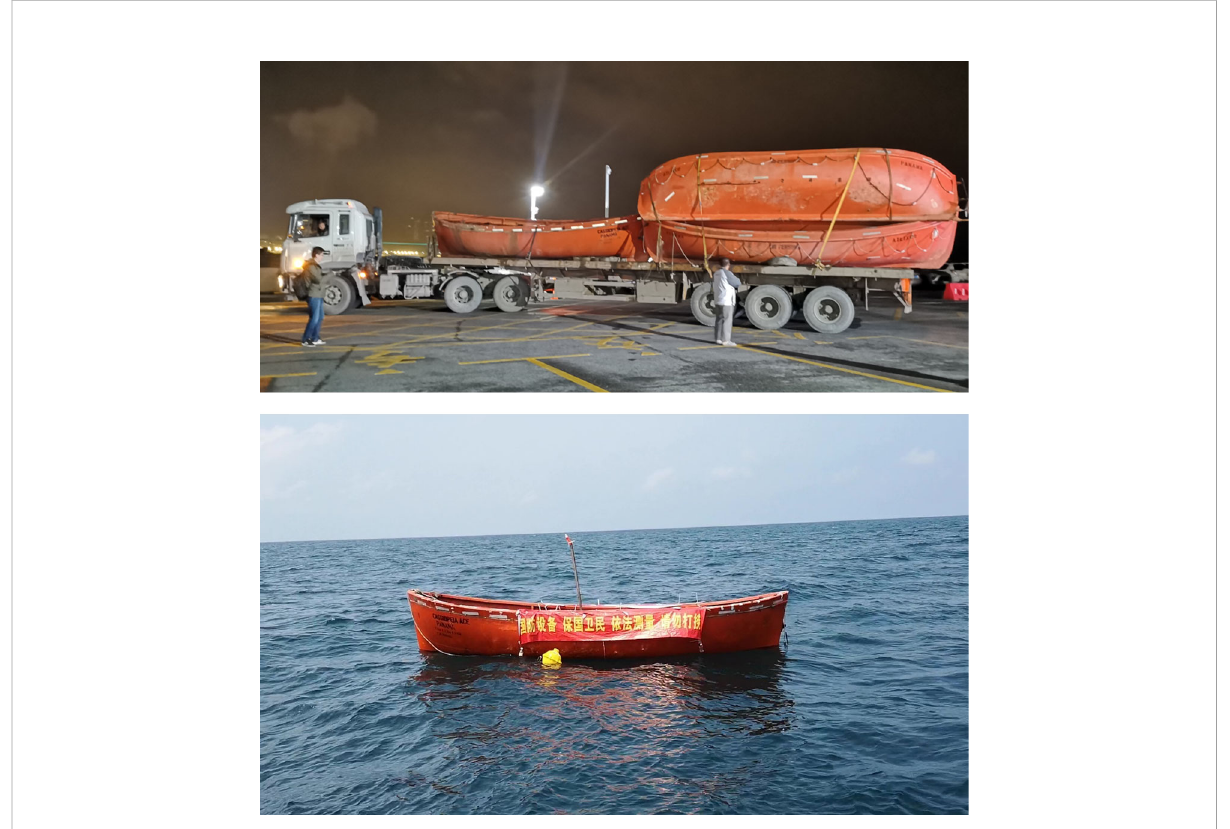
FIGURE 2 The open lifeboats used in the